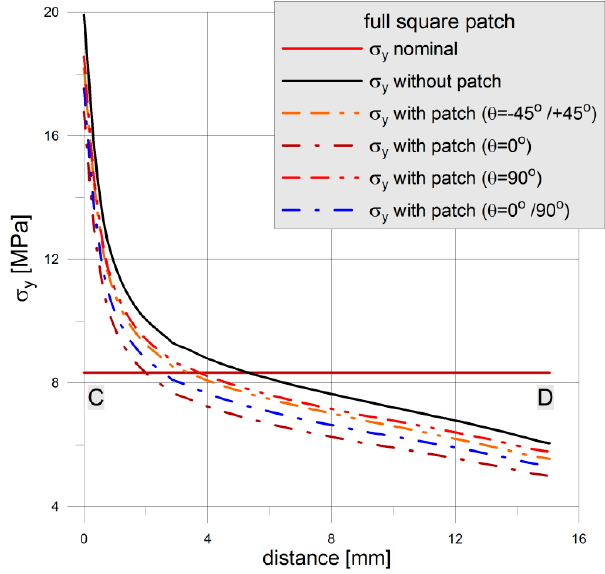
Figure 30. Distribution of tension stress σ ycomp for top composite layer for square patch (45 × 45), for different fiber angle